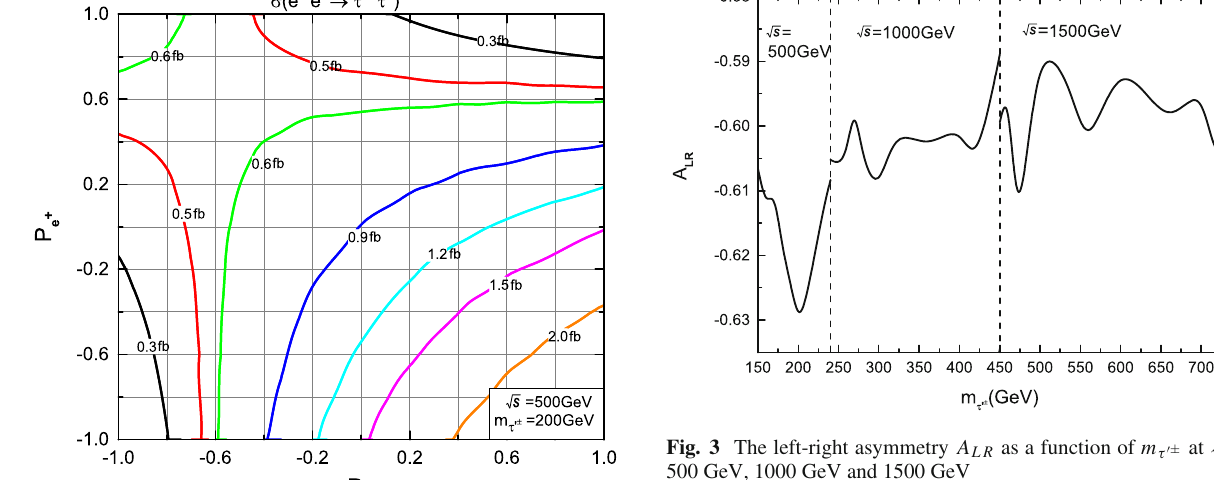
Fig. 3 The left-right asymmetry A LR as a function of m τ (cid:2)± at 500 GeV, 1000 GeV and 1500 √ s = 500 GeV, and the